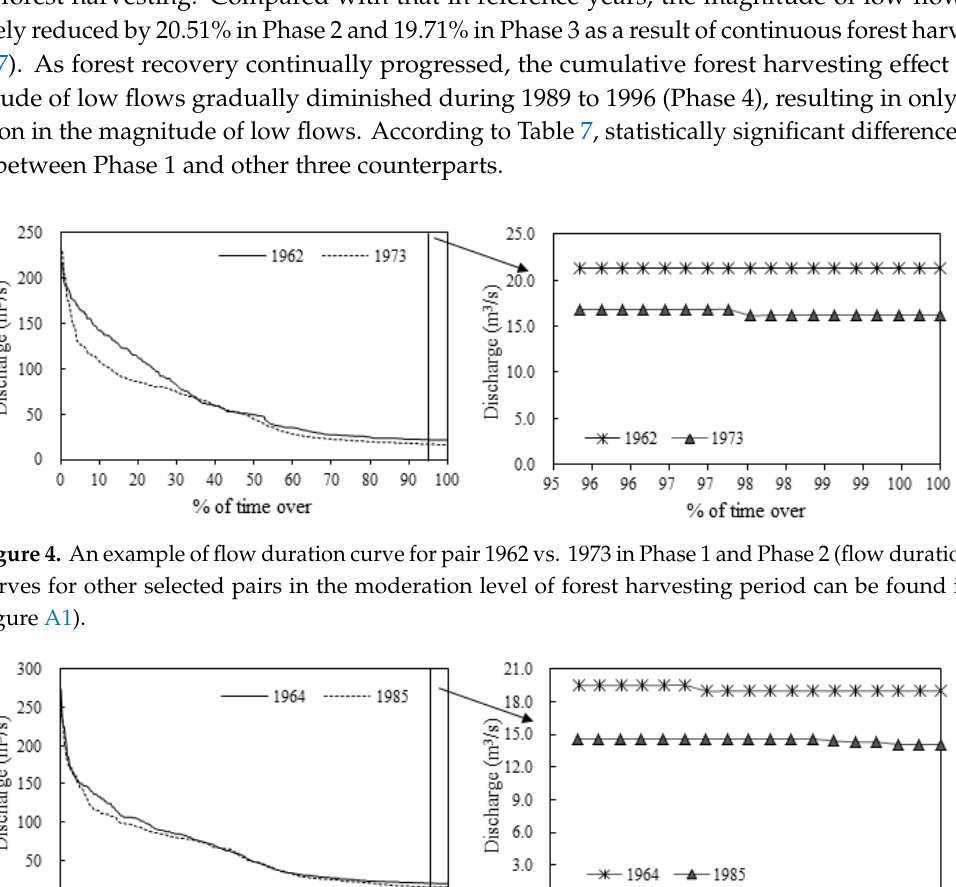
Figure 6. An example of flow duration curve for pair 1961 vs. 1991 in Phase 1 and Phase 4 (flow duration curves for other selected pairs in forest recovery period can be found in Figure A3).